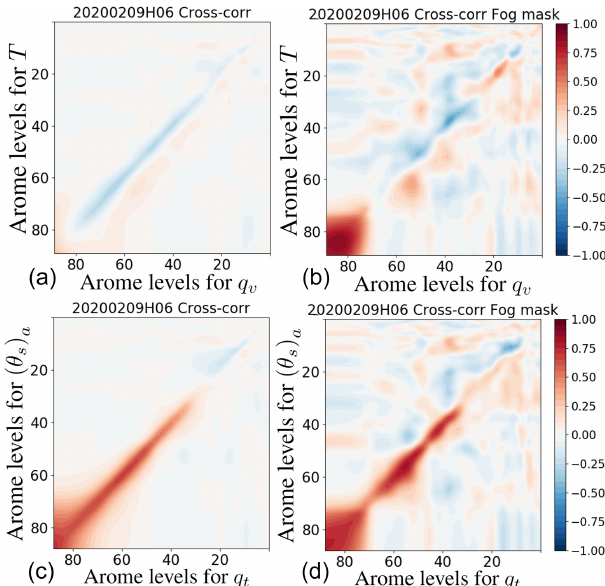
Figure 3. Background error cross-correlation matrices at 06:00UTC 9 February 2020 without (a, c) and with (b, d) a fog mask. (a, b) Between the classical variables ( T,q v ). (c, d) Between the new conservative variables ( (θ s ) a ,q t ). The axes correspond to the levels of the AROME vertical grid (1 at the top and 90 for the first level above the surface). Correlations are between − 1 (blue) and 1 (red) as shown in the colour bars (the same for the four plots).